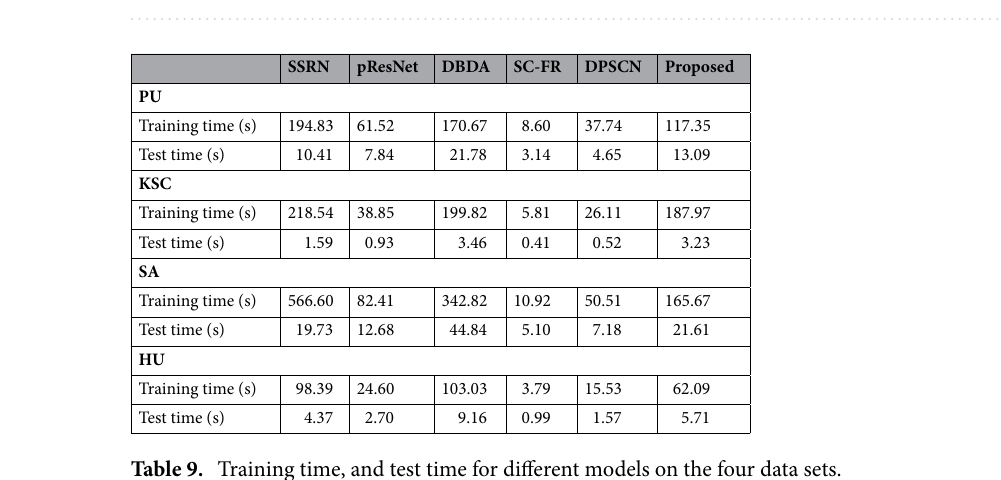
Figure 16. Part of the classification map for different models on the SA dataset. ( a ) Ground-truth map. ( b ) MLP. ( c )1D-CNN. ( d ) M3D-DCNN. ( e ) SSRN. ( f ) pResNet. ( g ) DBDA. ( h ) SCFR. ( i ) DPSCN. ( j ) DBFFT.